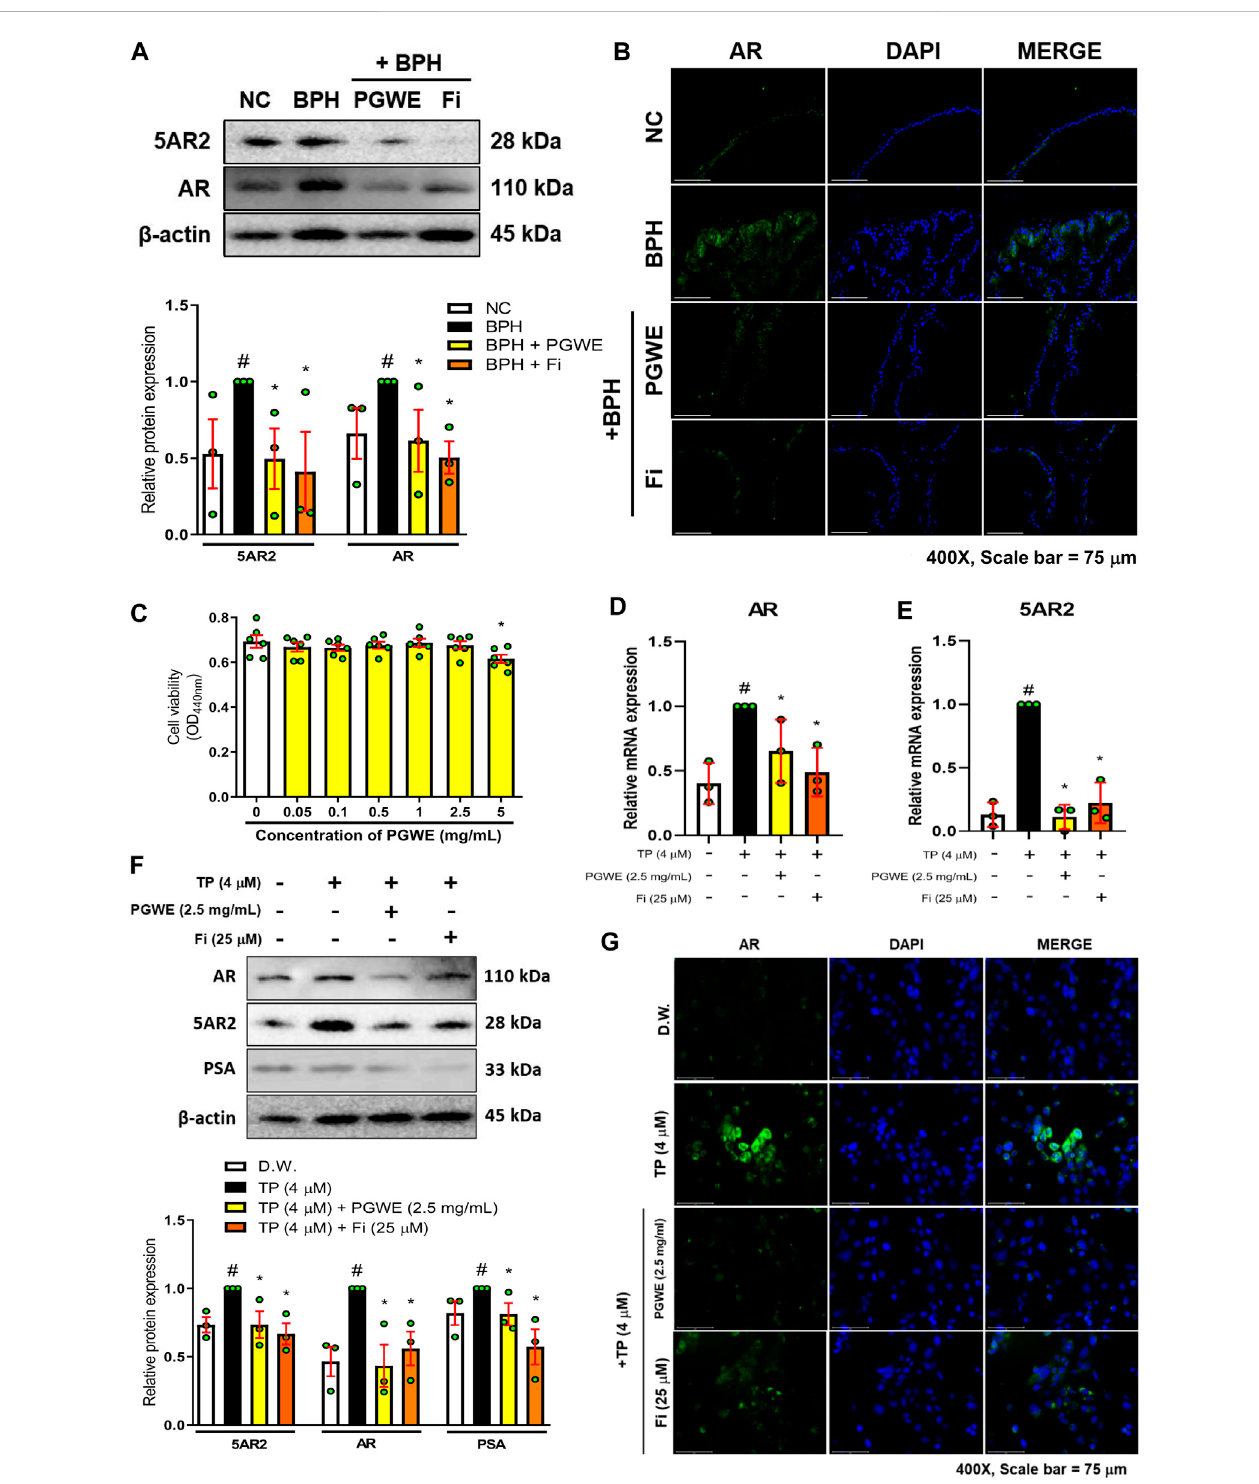
FIGURE 3 PGWE reduces 5AR2 and AR levels in prostate tissues of BPH rats and TP-treated RWPE-1 cells (A) The expressions of AR and 5AR2 in prostate tissues of TP-induced BPH rats were analyzed by western blotting. The loading control was β -actin (B) An immuno fl uorescence assay of AR was conducted in the prostate tissue (magni fi cation × 400, scale bar 75 µm) (C) RWPE-1 cells were treated with various concentrations of PGWE for 24 h to assay cell viability (D, E) RelativemRNAexpressionsof5AR2andARweredeterminedbyRT-PCR (F) TheproteinexpressionsofAR,5AR2,andPSAinRWPE-1cellswereanalyzed by western blotting and β -actin was used as the loading control (G) Immuno fl uorescence assay of AR was conducted in RWPE-1 cells (magni fi cation × 400, scale bar 75 µm). All data are expressed as mean ± SEM of independent experiments. Statistical differences were evaluated using an unpaired t -test and a subsequent post hoc one-tailed Mann-Whitney U test. # p < 0.05 vs. NC groups or DW-treated RWPE-1 cells; p p < 0.05 vs. BPH group or TP-treated RWPE-1 cells. NC, normal control; BPH, benign prostatic hyperplasia; TP, testosterone propionate; PGWE, Panax ginseng C. A. Meyer water extract; Fi, fi